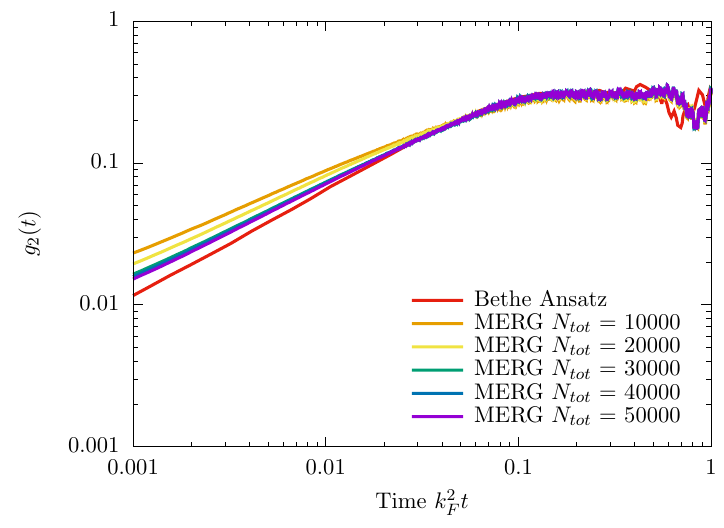
( 0 ) following the 2 . i